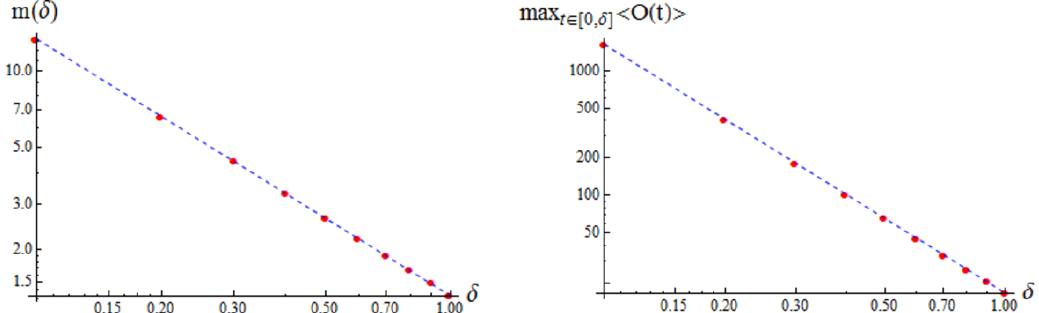
Figure 10 . Left: log-log plot of m ( (cid:14) ) (red dots) and the (cid:12)tting curve m ( (cid:14) ) / (cid:14) (cid:0) 1 (blue dashed) for the quench pro(cid:12)le (5.2) with (cid:11) b as in (5.1). Right: log-log plot of max and the (cid:12)tting curve max hO (cid:30) ( t ) i / (cid:14) (cid:0) 2 (blue dashed) for the same quench process as in the t 2 [0 ;(cid:14) ] left plot.